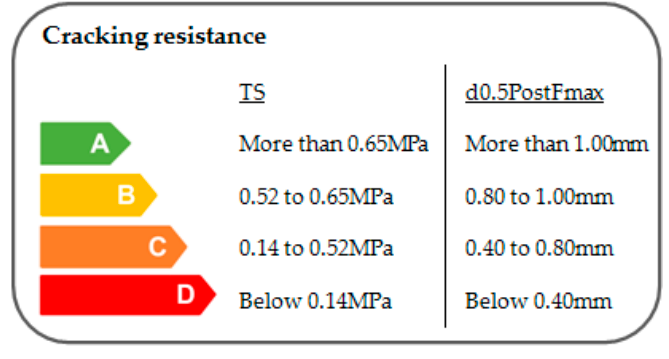
Figure 18. Cracking resistance label.